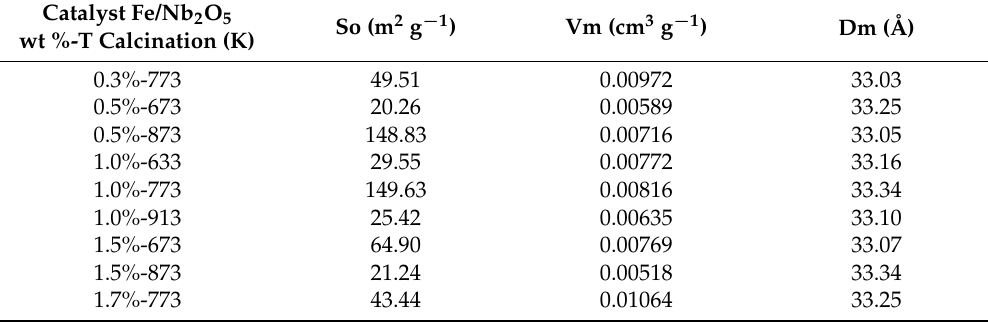
Table 1. Summarizes the surface textural properties catalysts (Specific surface area (So), Micropore Volume (Vm), and average pore diameter (Dm).